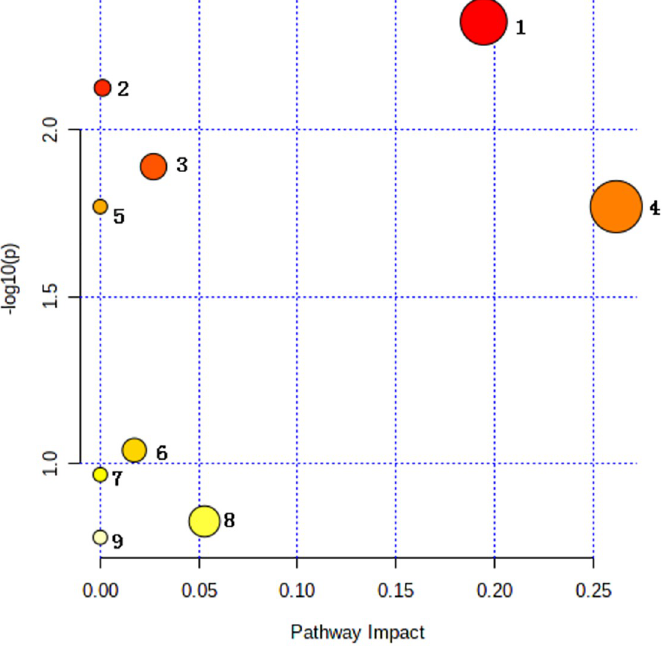
Fig 10. The view of nine affected metabolic pathways between two groups. 1 Tryptophan metabolism pathway, 2 Tyrosine metabolism pathway, 3 Glutathione metabolism pathway, 4 Phenylalanine metabolism, 5 Phenylalanine, tyrosine and tryptophan biosynthesis, 6 Pyrimidine metabolism pathway, 7 Aminoacyl-tRNA biosynthesis pathway, 8 Porphyrin and chlorophyll metabolism pathway, 9 Riboflavin metabolism pathway.